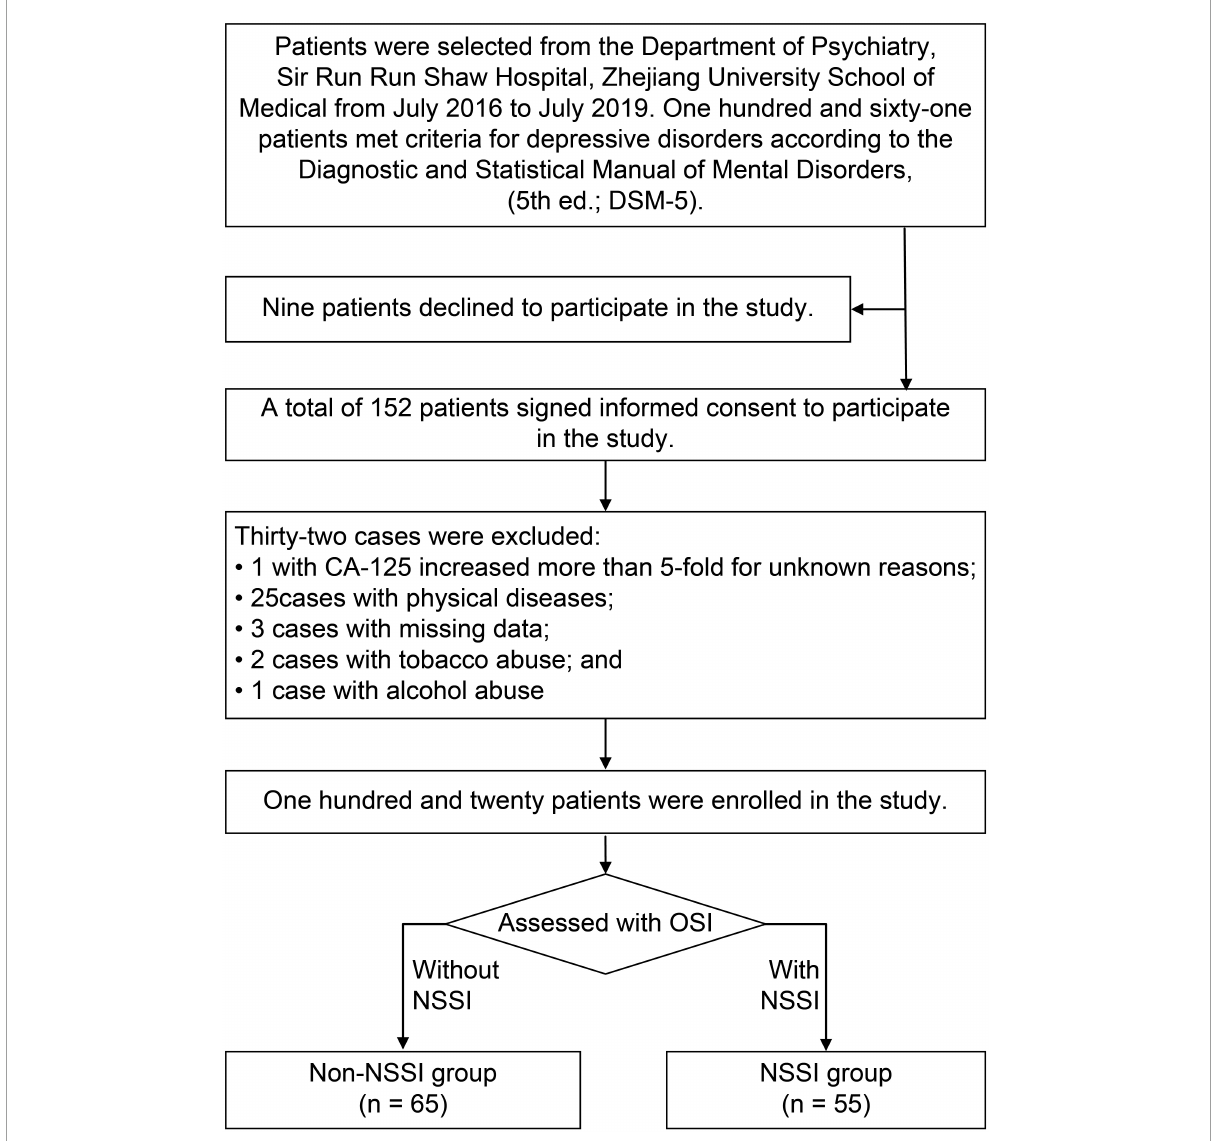
FIGURE1 Study flowchart.